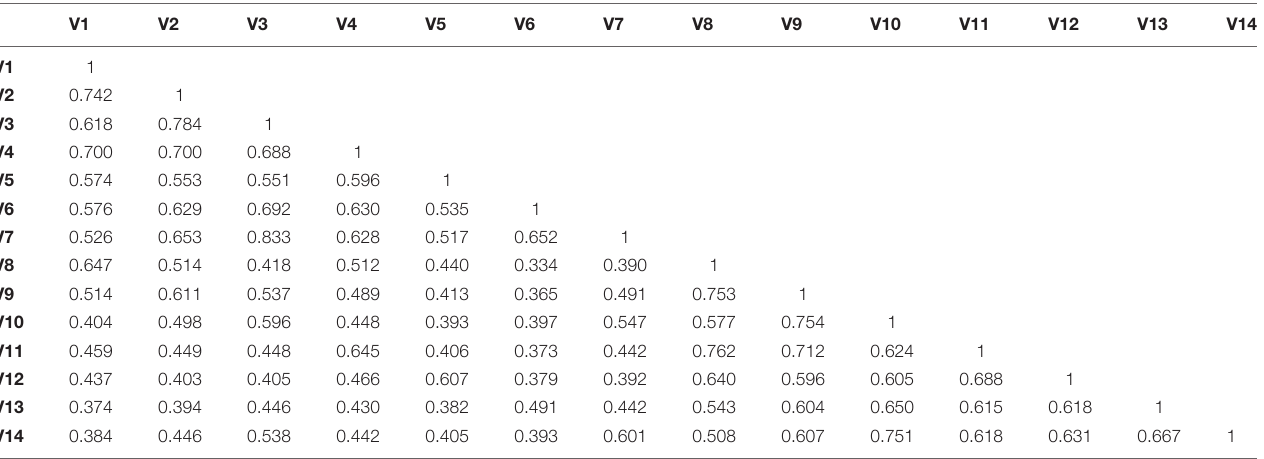
TABLE 2 | Polychoric correlations – EBIPQ-ECD.